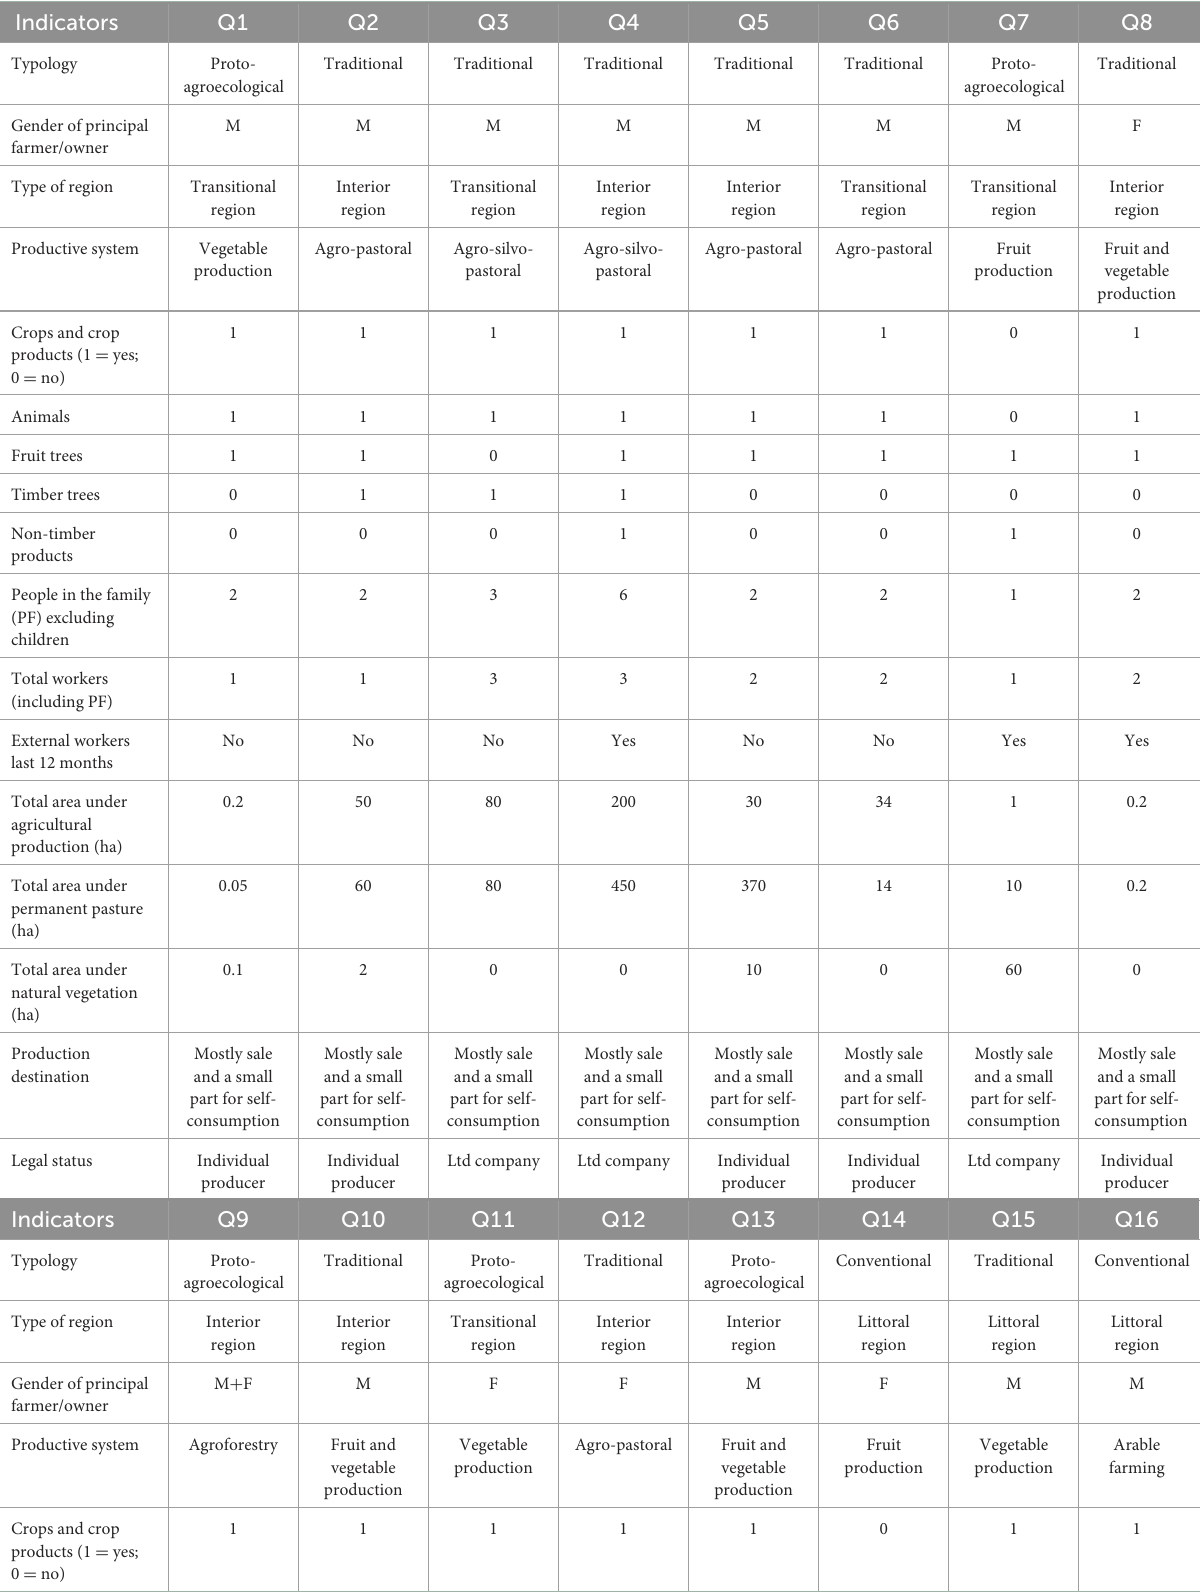
TABLE 2 Description of assessed farms in the Odemira region.